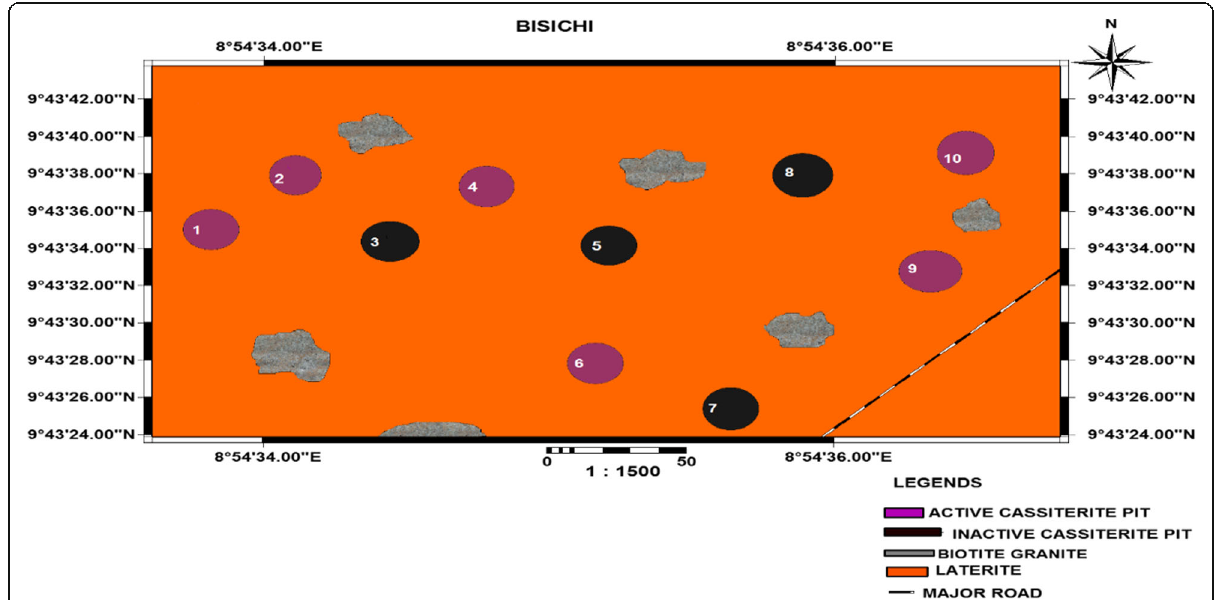
Fig. 2 An image of Bisichi (Kara II) in Plateau State showing active and inactive pit